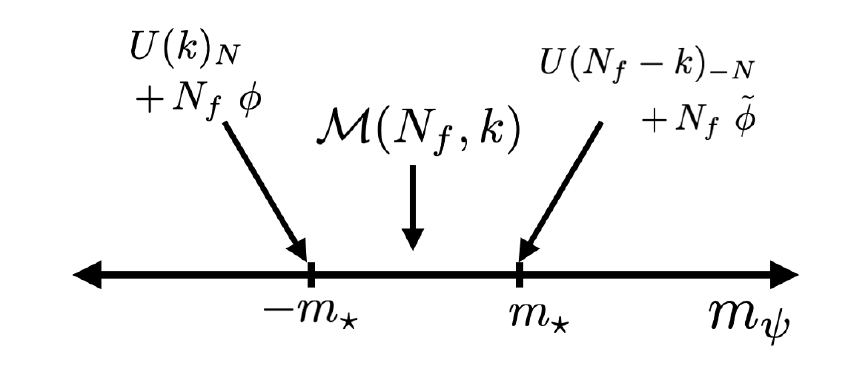
Figure 1 . Symmetry breaking of QCD 3 according to